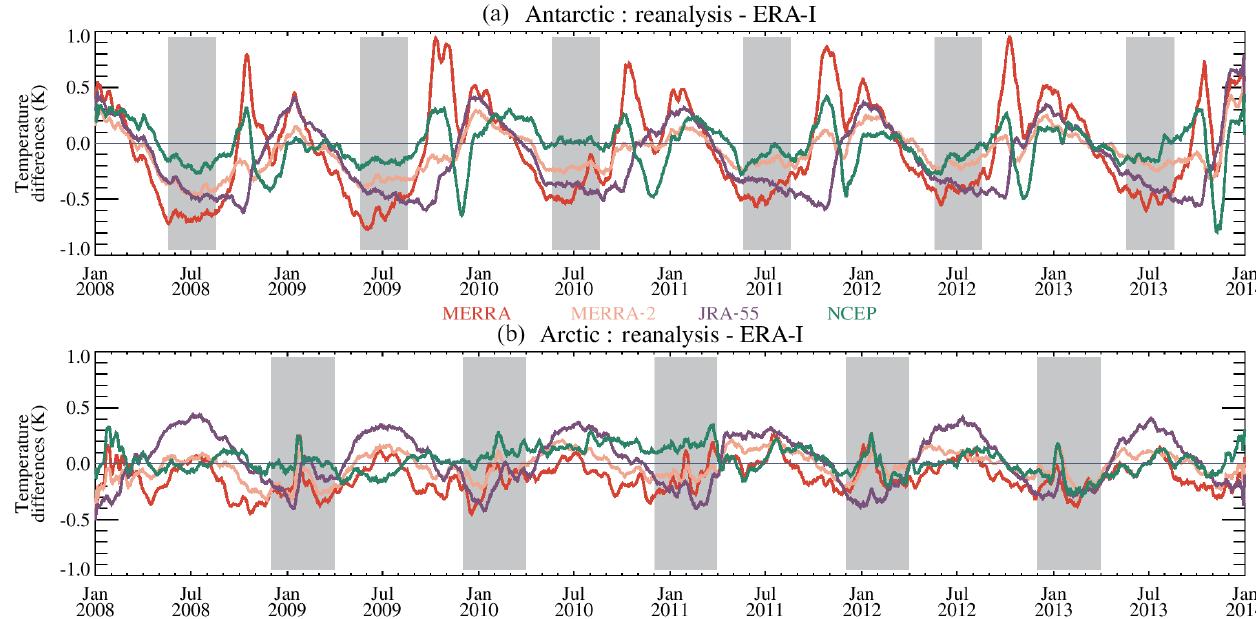
Figure 3. (a) Time series (for 12:00UT) from 2008 to 2013 of 10-day boxcar smoothed temperature differences for MERRA, MERRA-2, JRA-55, and NCEP-CFSR, relative to ERA-I at 46hPa and averaged over the 60 ◦ Antarctic polar cap. The gray regions indicate the periods defined for the analysis of PSC-related metrics. Panel (b) shows a similar case, except for the Arctic. (cid:17) 2 (cid:16) T (cid:48) , is related to the potential energy density of ance ¯ T